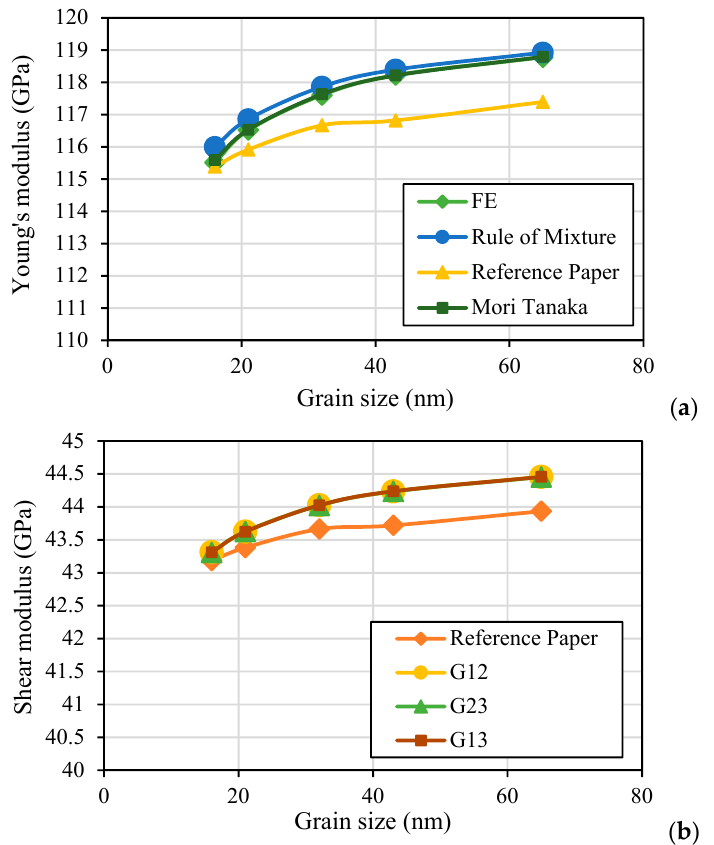
Figure 14. Comparison of FE and analytical outcomes of nanostructured materials for ( a ) Young’s modulus of elasticity and ( b ) Shear modulus in each of three material directions, applying a constant value of 1 nm for the GB thickness. Metals 2019 , 9 , 202